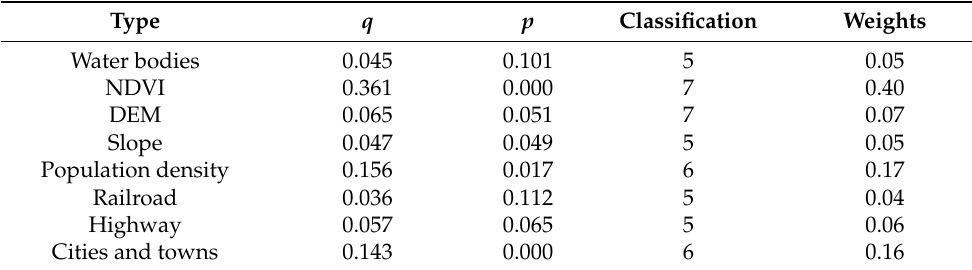
Table 2. Weight assignment based on Geodetector.